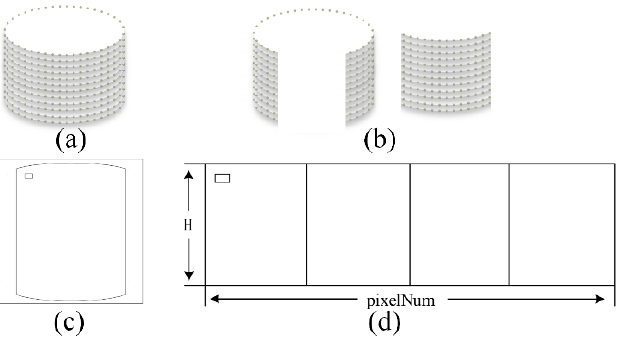
Figure 11. Structure of experimental system.